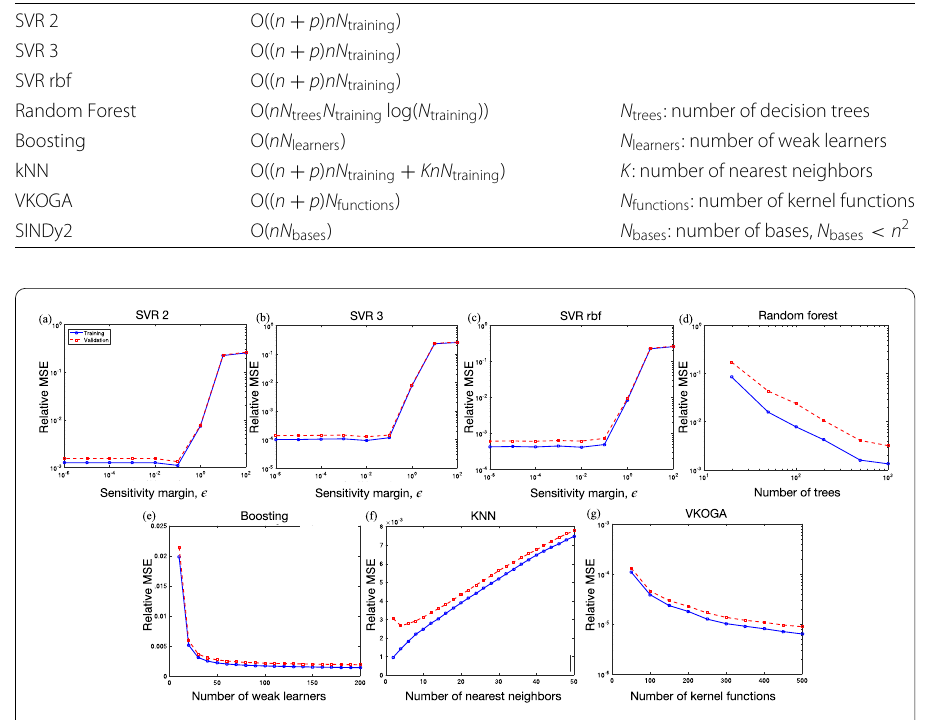
Table 5 Theoretical complexity per time step, where n represents the subspace dimension, p represents the parameter dimension, and N training represents the number of training points Method